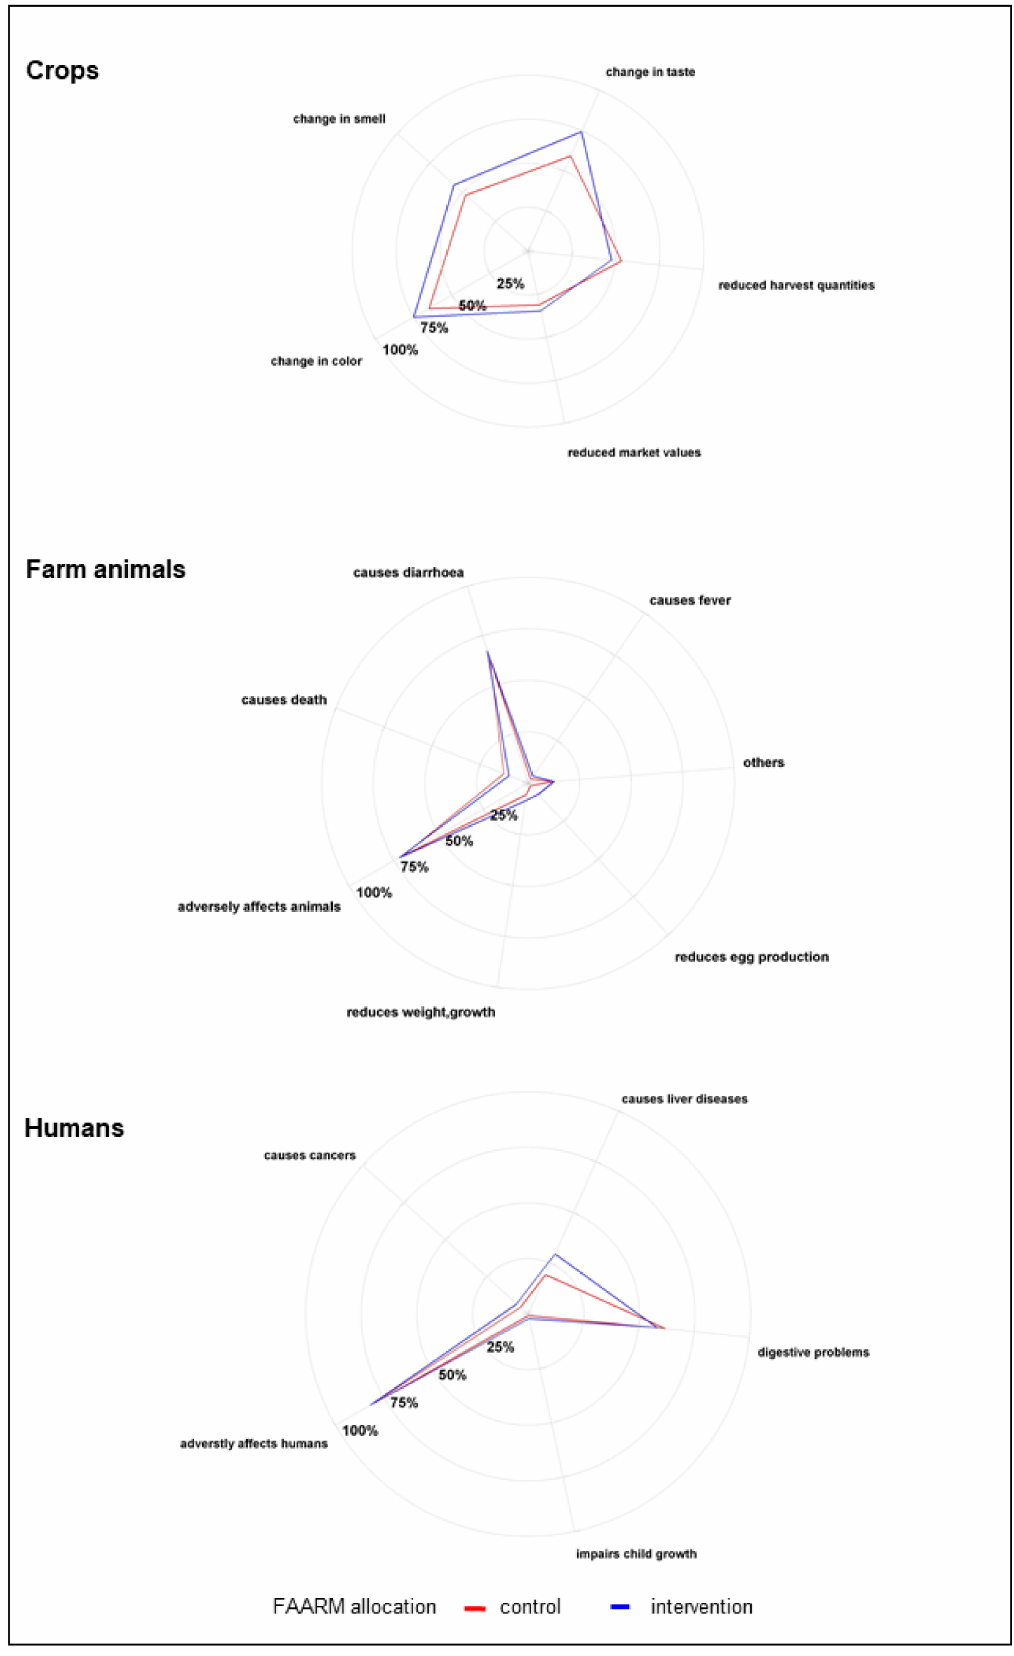
Figure 3. Harmful effects of mold contamination ( n =